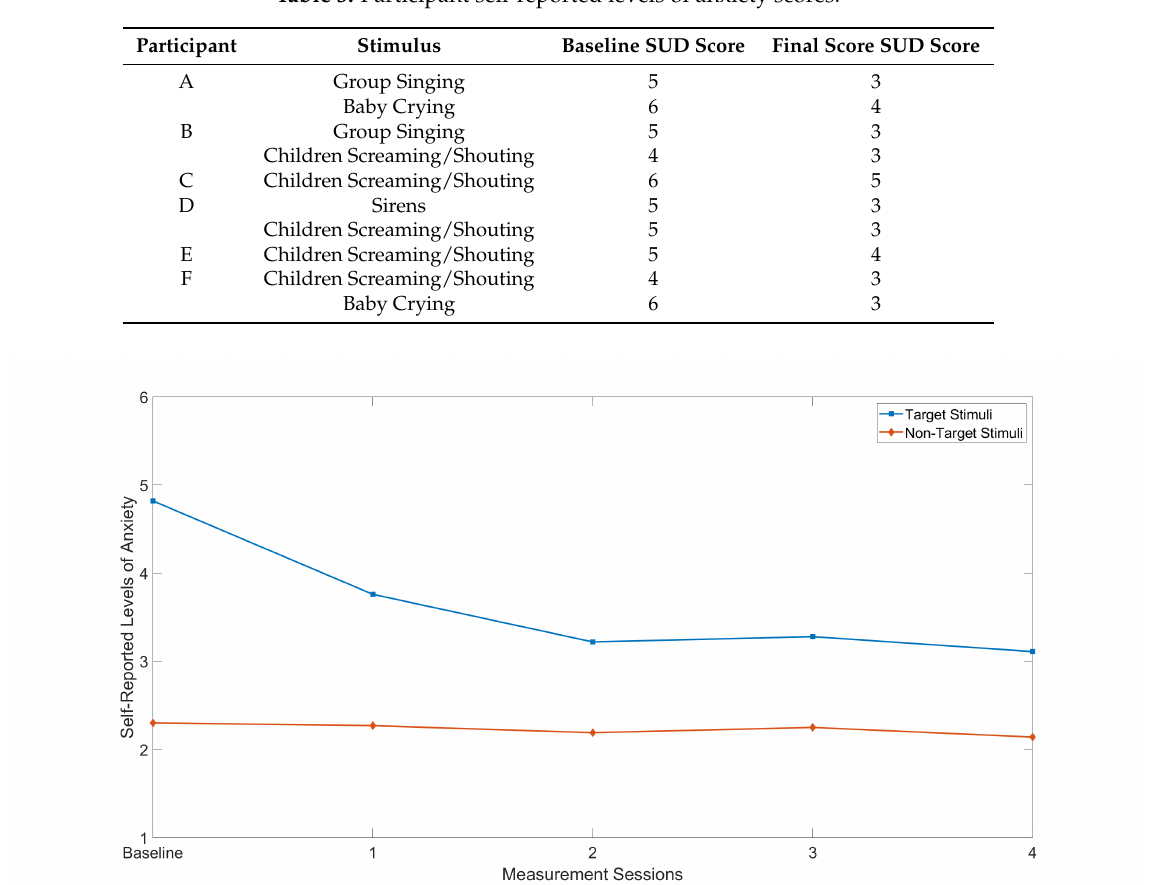
Table 3. Participant self-reported levels of anxiety scores.